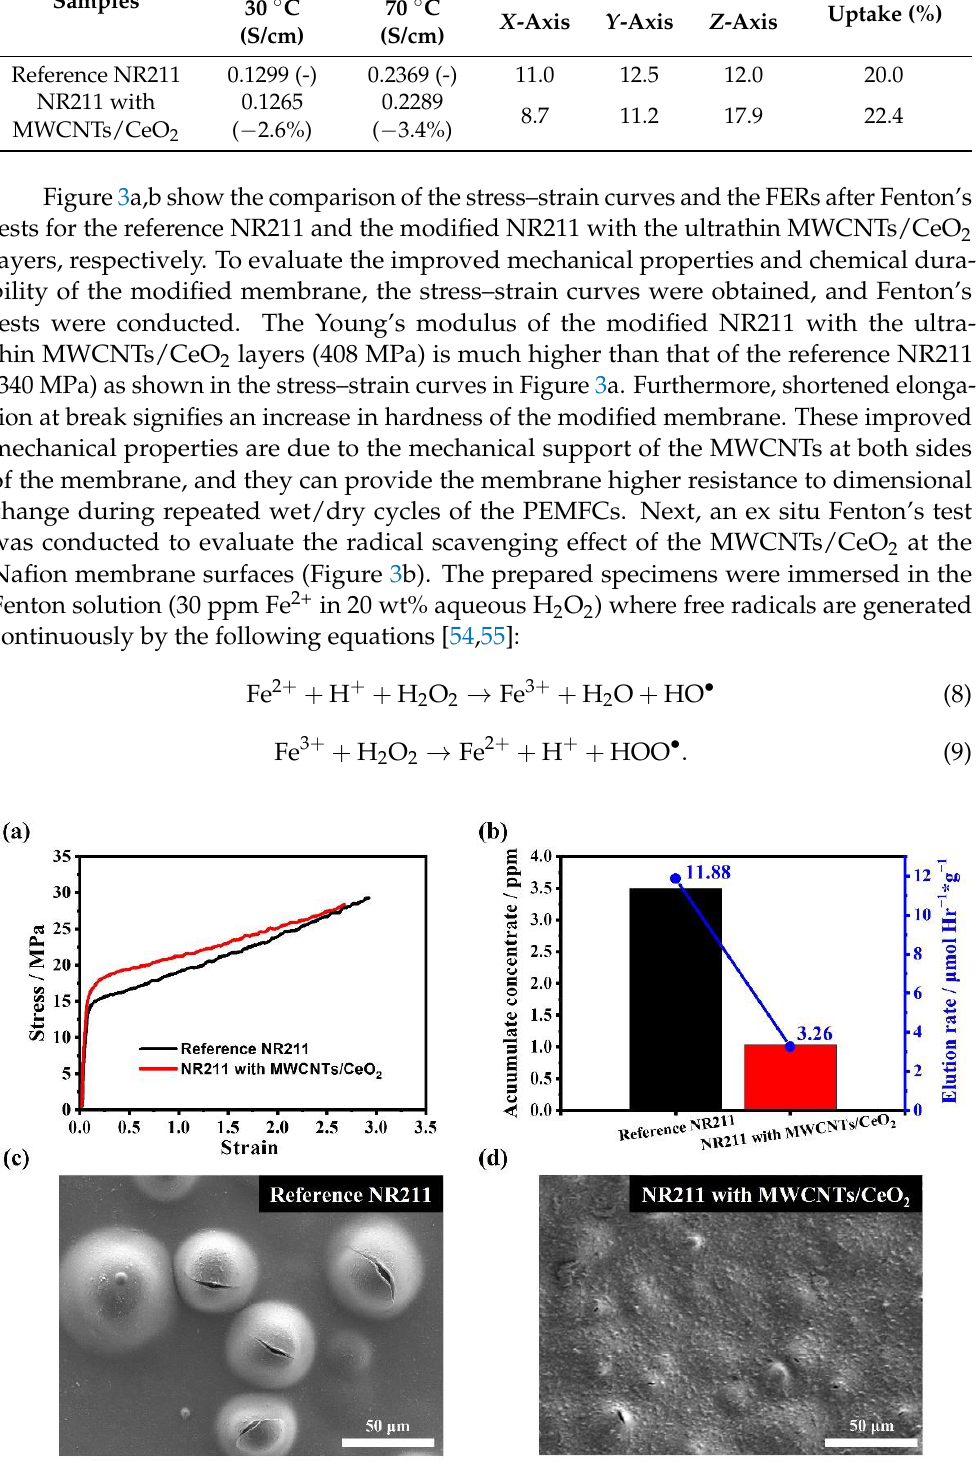
Figure 3. Comparison of ( a ) the stress–strain curves and ( b ) the fluorine emission rates (FERs) after Fenton’s test for the reference NR211 and the modified NR211 with MWCNTs/CeO 2 . Magnified SEM surface images of ( c ) the reference NR211 and ( d ) the modified NR211 with MWCNTs/CeO 2 after Fenton’s test.